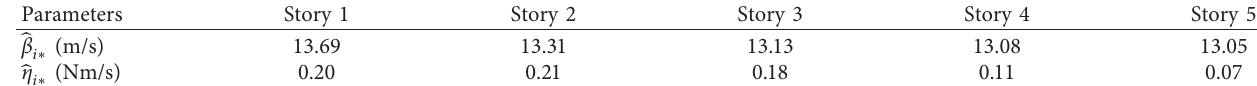
Table 1: Estimated shear wave velocities and Kelvin damping coefficients.